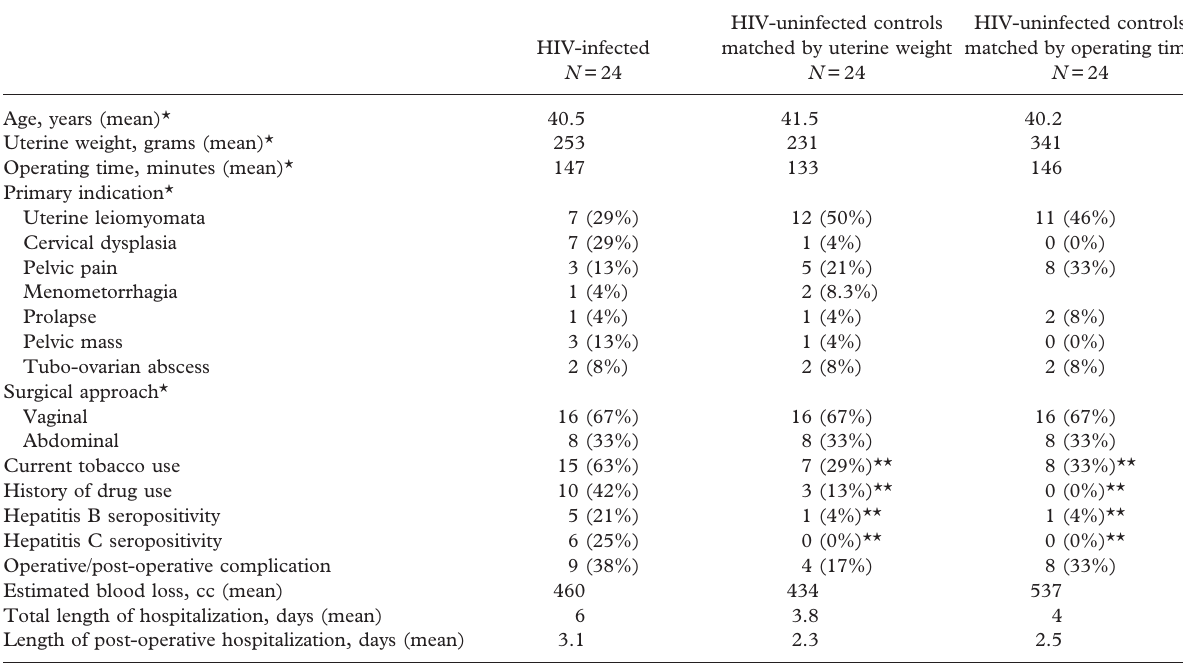
Table I. Characteristics of the 72 women in the study population.